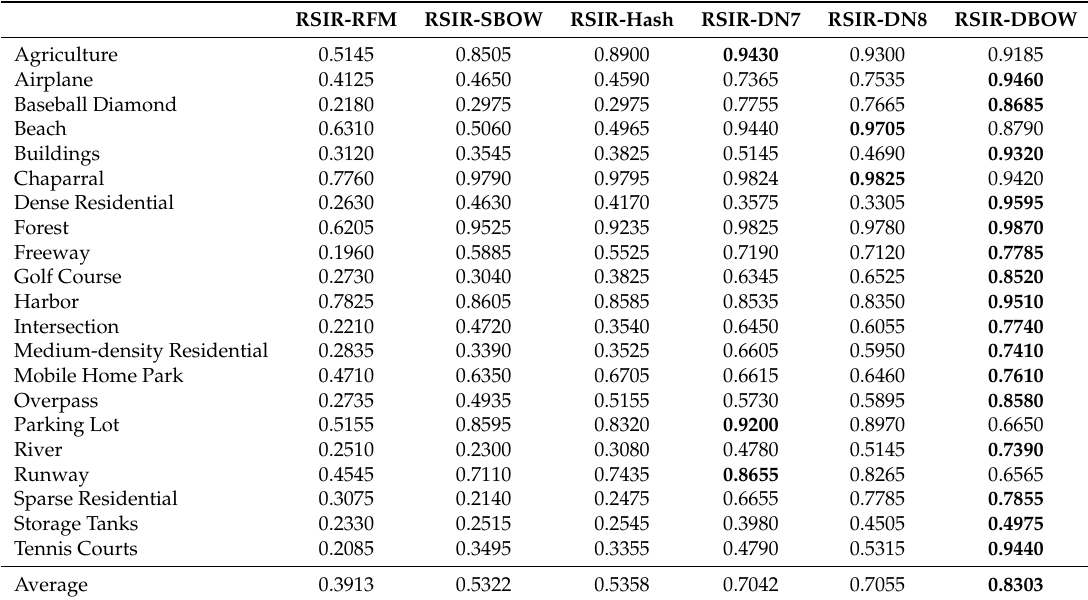
Table 3. Retrieval precision of different remote sensing image retrieval methods across 21 semantic categories in ImgDB1 counted by the top 20 results.